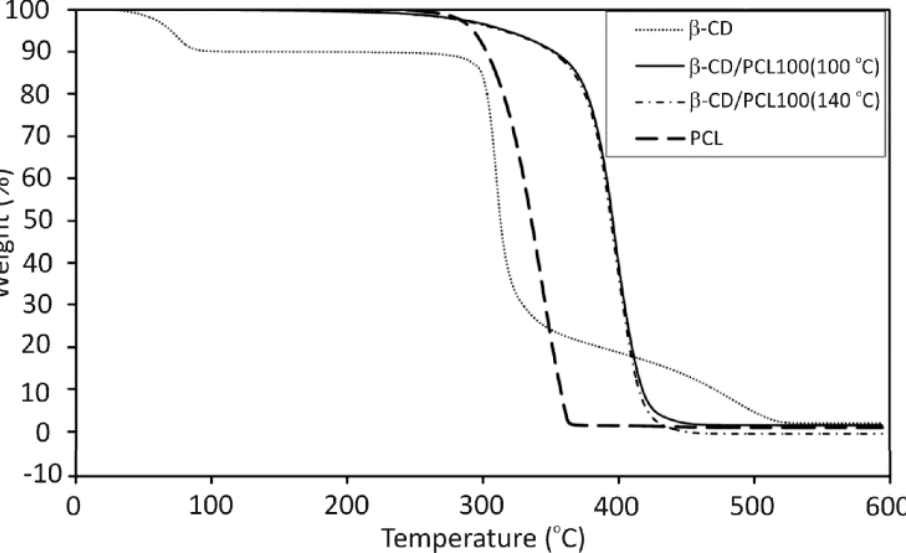
Figure 5. Thermogravimetric analysis (TGA) thermograms of the β CD/PCL100 polymer and native β -CD.